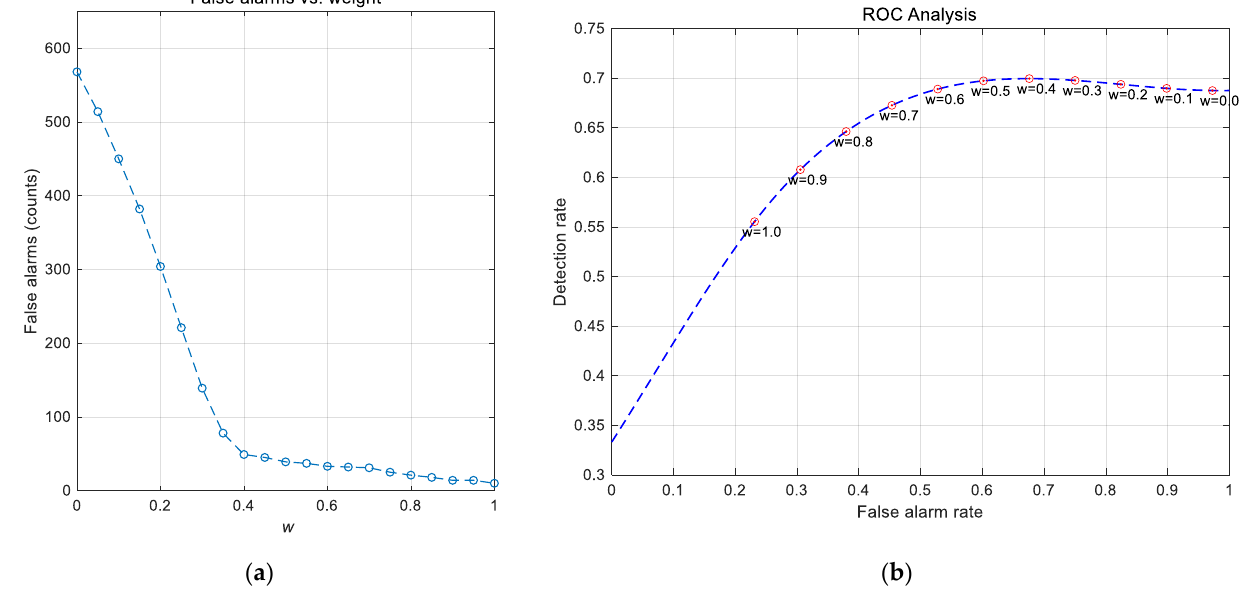
Figure 10. ( a ) Variation of the total number of false alarms and ( b ) ROC curve derived from different weights in Equation (6). The total number of false alarms decreases up to w = 0.4 with a steep slope, which implies the method significantly reduces the false alarm rate. The area under the curve (AUC) is 0.62. The false alarm rate is close to 1.0 when w = 0, which is the case of the image before ghost removal. The detection rate reaches to the maximum at w = 0.5 with a false alarm rate of about 0.6. The maximum detection rate did not reach 1.0 because some small boats in relation to the ground resolution of TSX fail to be detected.